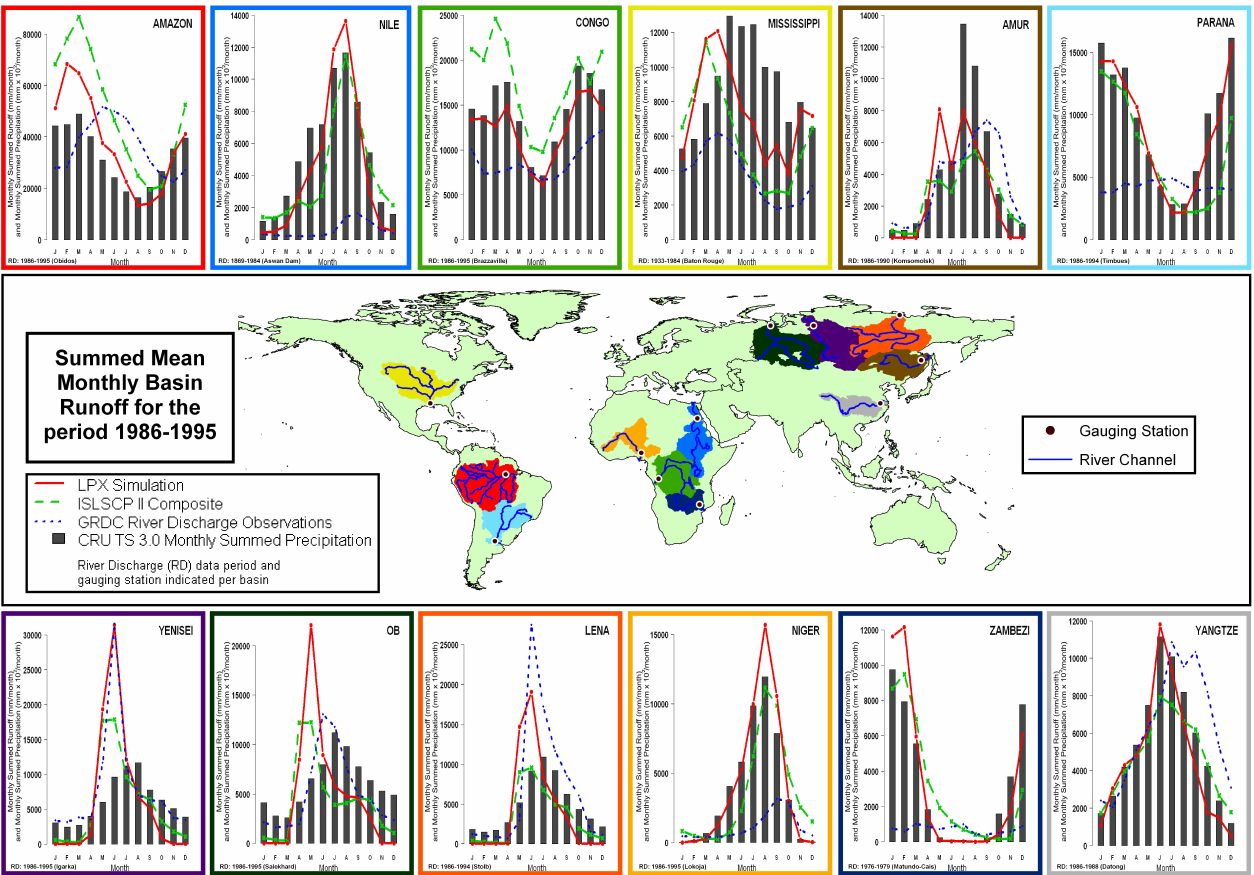
Fig. 6. Summed monthly catchment runoff averaged for 1986–1995 as represented by LPX, the ISLSCP II composite data and GRDC disaggregated mean monthly river discharge observations converted to runoff equivalent. Also shown are CRU TS 3.0 monthly summed precipitation observations. Basins shown on the map are associated with the graph of the same colour